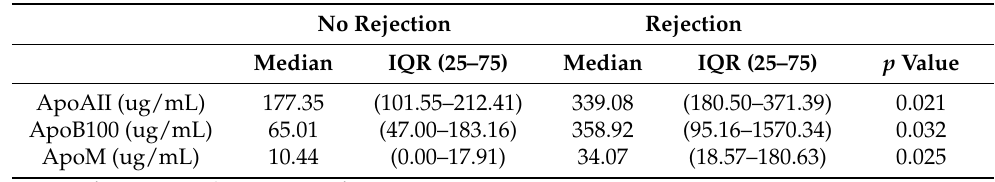
Table 4. Relationship between donor’s pericardial apolipoprotein levels and ISHLT Grade ≥2R rejection.